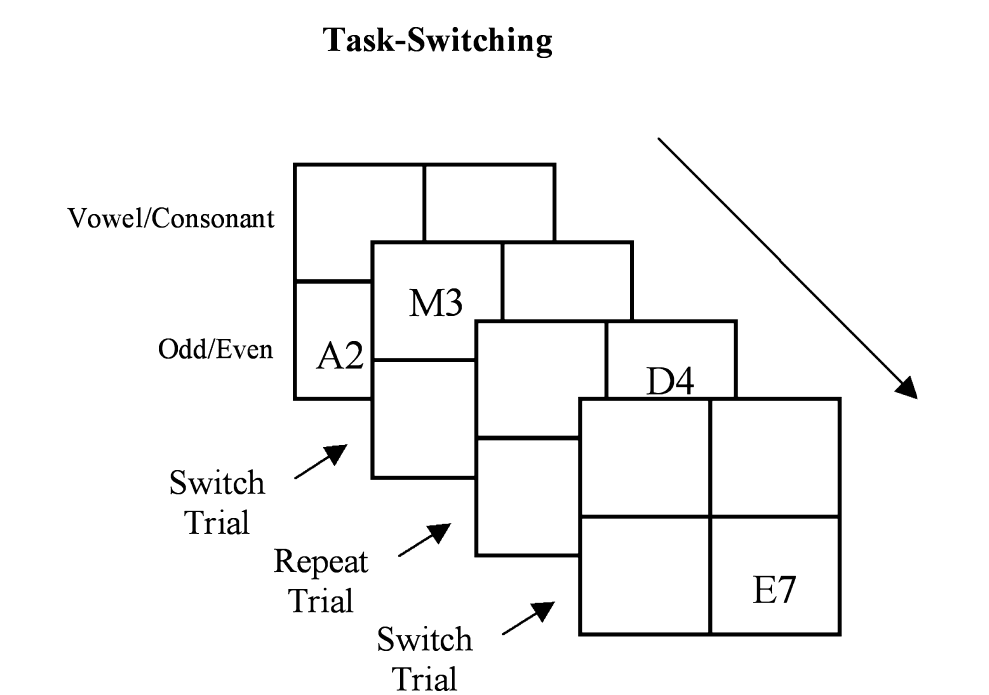
Figure 1 | Description of the task-switching paradigm. Letter and digit stimuli were presented simultaneously in a 2 × 2 grid and participants had to switch between responding to the letters versus responding to the numbers on every 3rd trial (adapted from Rogers and Monsell,